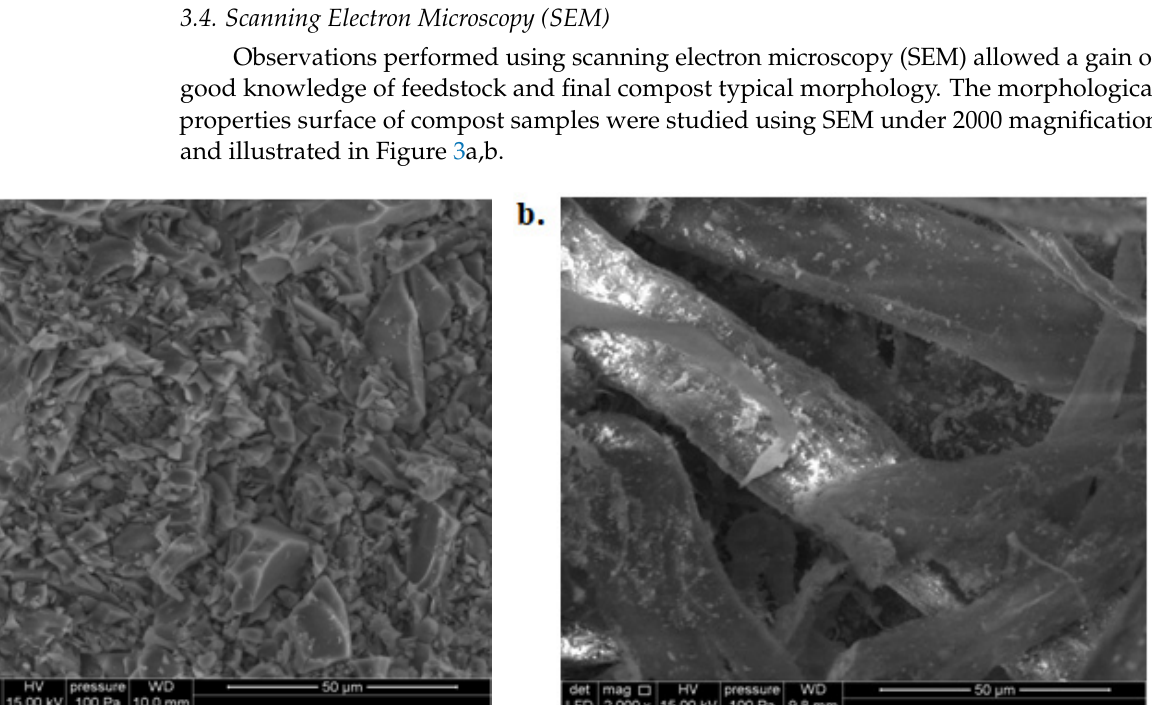
Table 4. Assignments of the main vibrations of the Infrared spectra.